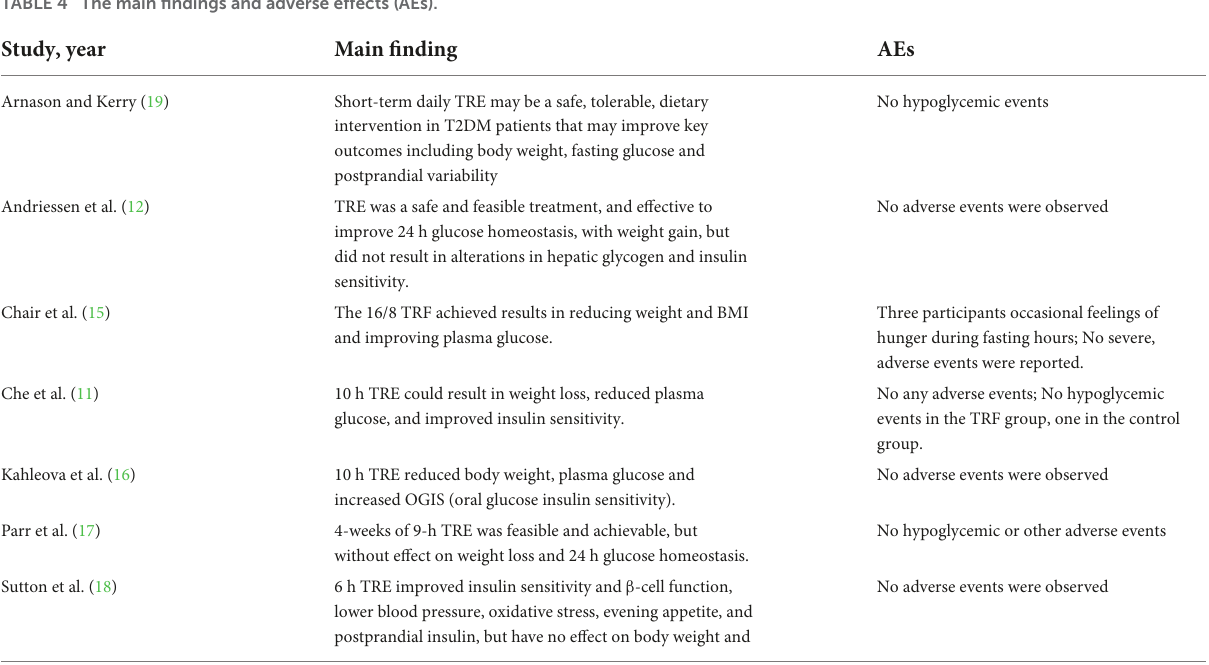
TABLE 4 The main findings and adverse effects